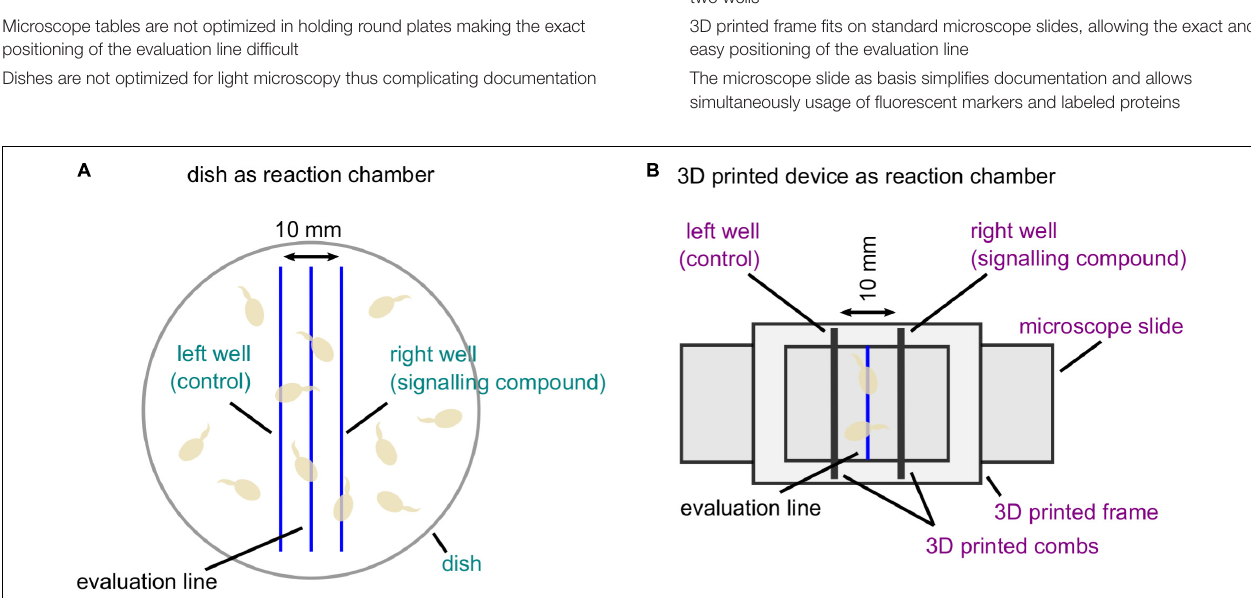
FIGURE 1 | Comparison of two different reaction chambers for the analysis of directed fungal growth. (A) Classical setup of the chemotropic assay based on a dish as reaction chamber (Turrà et al., 2015). A dish is filled with water agar mixed with fungal conidia (light brown). Along hand-drawn parallel lines, two wells are cut serving the application of the signaling compound and the solvent control. Along the evaluation line, the orientation of germ tube tips is evaluated. Error-prone methodical parts are indicated in turquoise. (B) Chemotropic assay using the new 3D printed device consisting of a frame and two combs. The 3D printed frame is fixed on a microscope slide coated with water agar providing a hand-drawn evaluation line. Two 3D printed combs are placed in provided slots with a distance of 10 mm to create reproducible wells. Fungal conidia (light brown) are applied on water agar topping the evaluation line. Improvements of the methodical setup are marked in